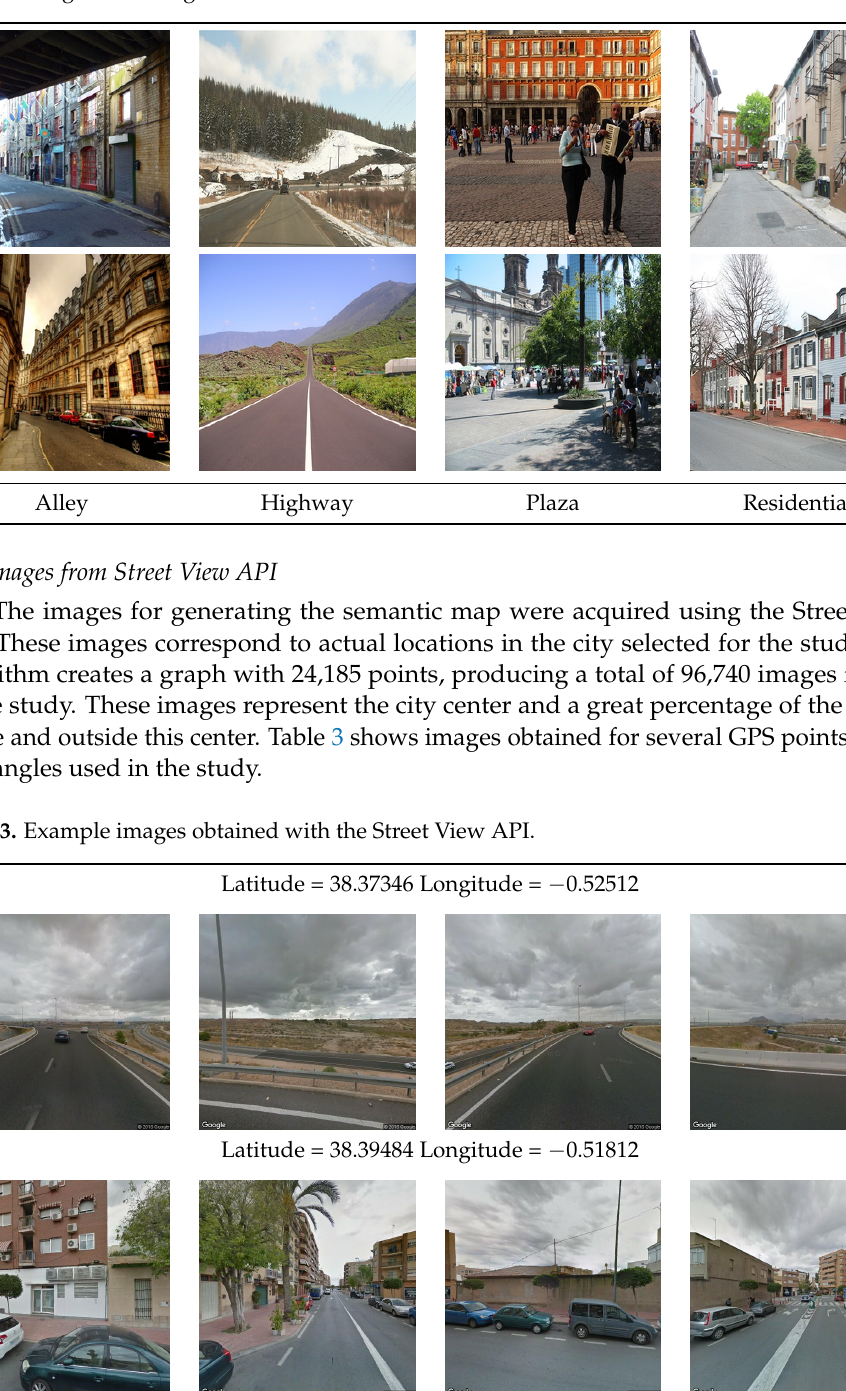
Table 2. Images and categories from the Places 205 dataset.